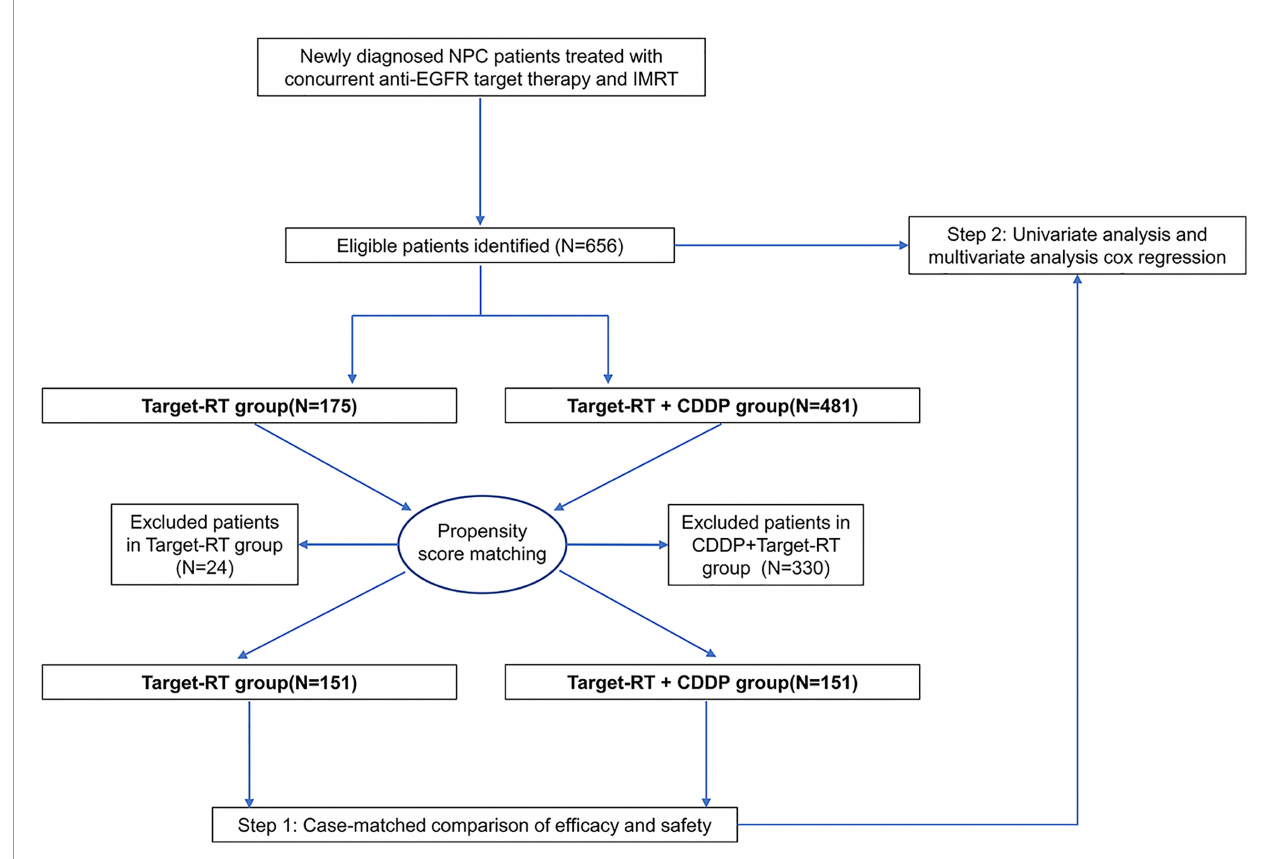
FIGURE 1 | Patient selection and research fl ow